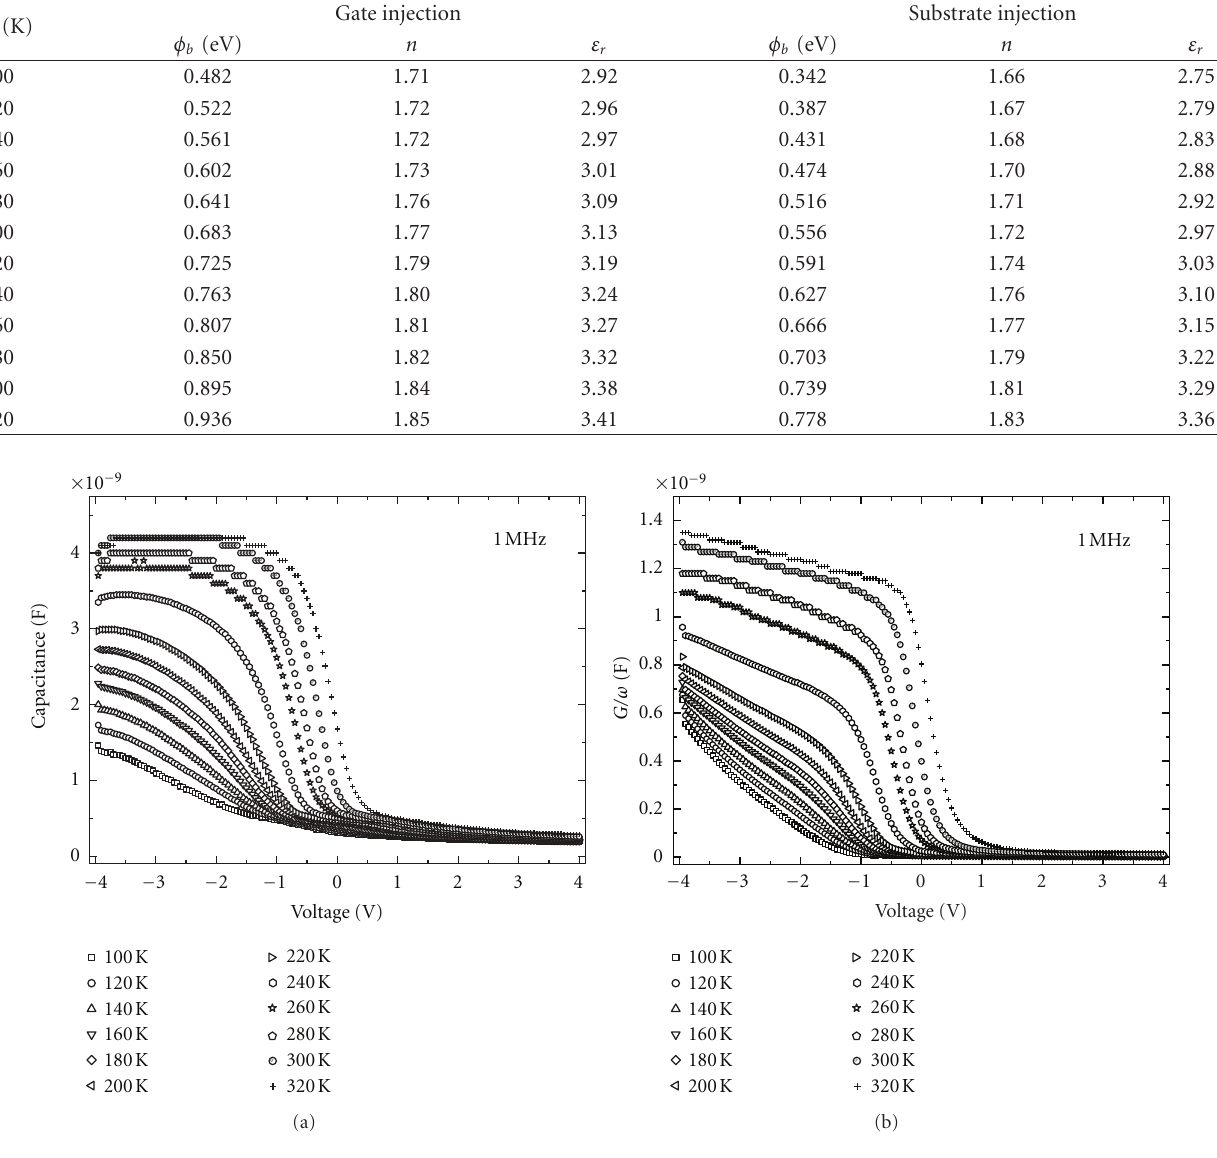
Figure 8: The temperature-dependent curves of the (a) C-V and (b) G/ ω -V characteristics of Al/HfO 2 /p-Si (MOS) structure as measured at